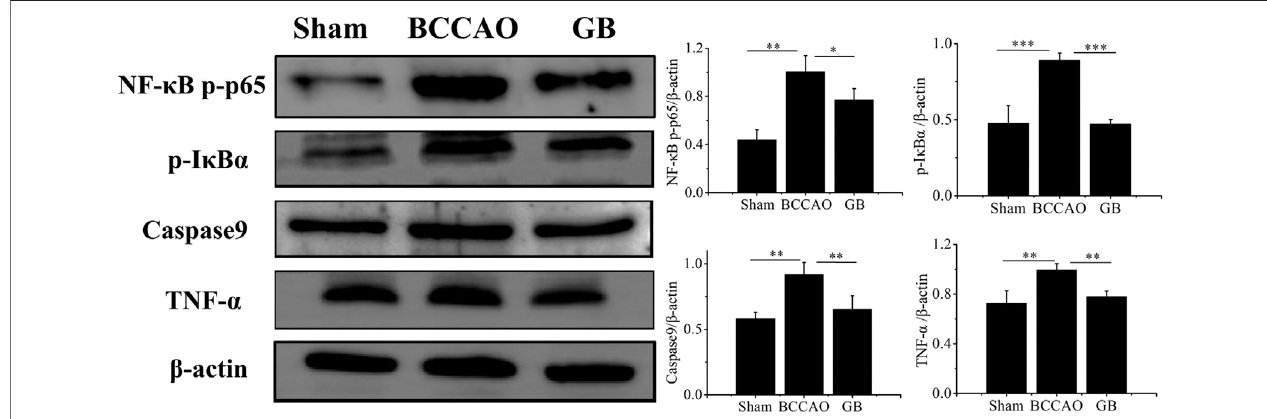
FIGURE8| DetectionoftheproteinlevelsofNF κ Bp-p65,p-I κ B α ,Caspase9andTNF- α inbraintissuebywesternblotting.Datarepresentedthemean ± SD( n (cid:1) 3), * p < 0.05,** p < 0.01, *** p < 0.001.